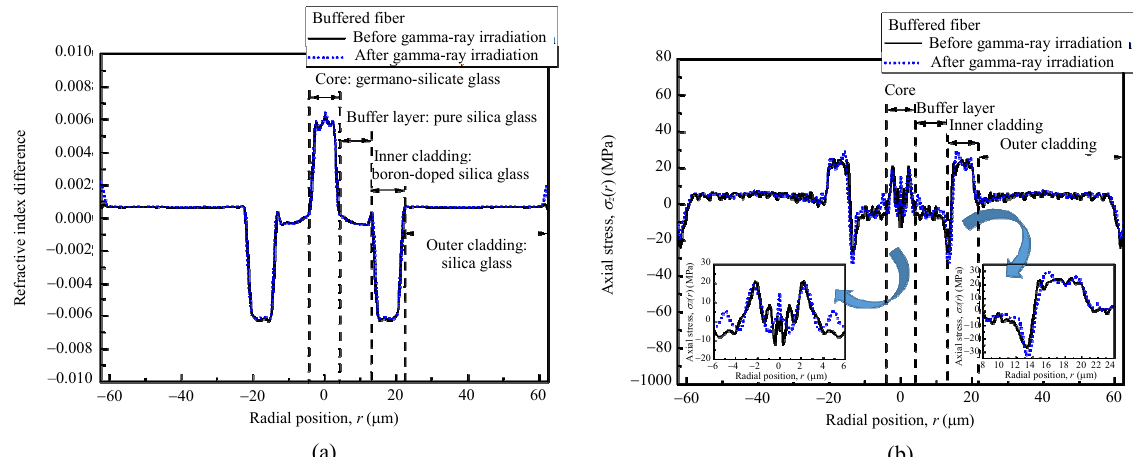
Fig. 3 Radial profiles of (a) refractive index and (b) residual stress of the buffered fiber before and after the γ -ray irradiation with the total dose of 22.85 kGy at room temperature in air (the inset image shows the enlarged residual stresses in the core and inner cladding